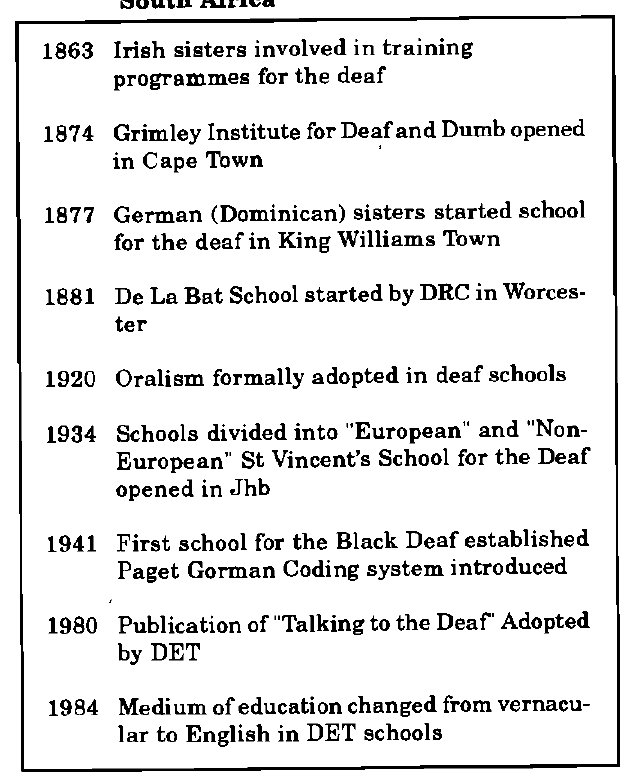
Table 1: Milestones in the history of Signing in South